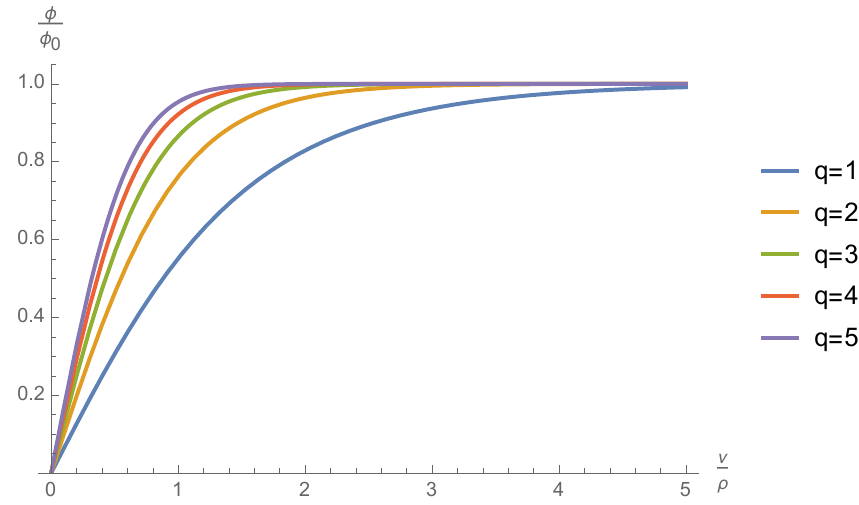
Figure 6 . Graphs of the exact double BPS kink ( l = 1) for small values of q